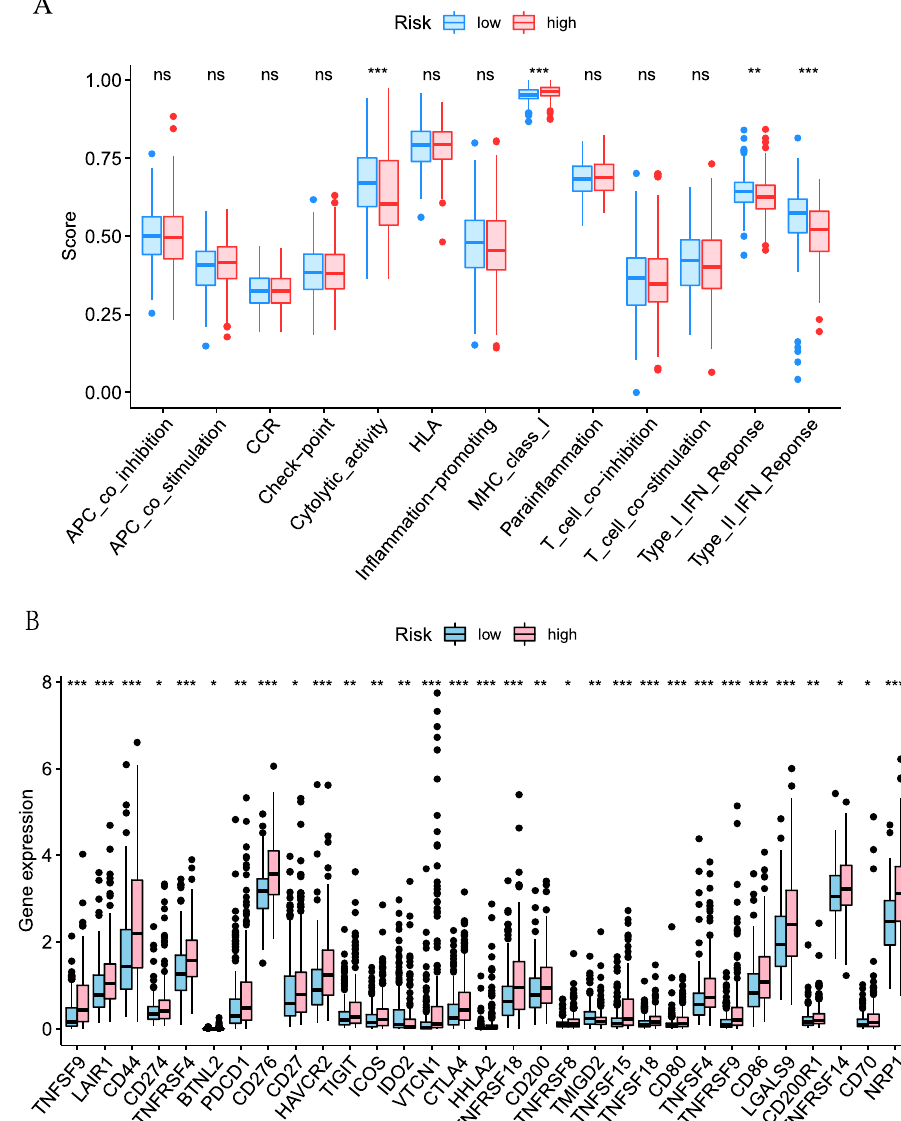
Figure 9. ( A ) ssGSEA for the association between immune cell subpopulations and related functions ( B ) Expression of immune checkpoints between high- and low- risk